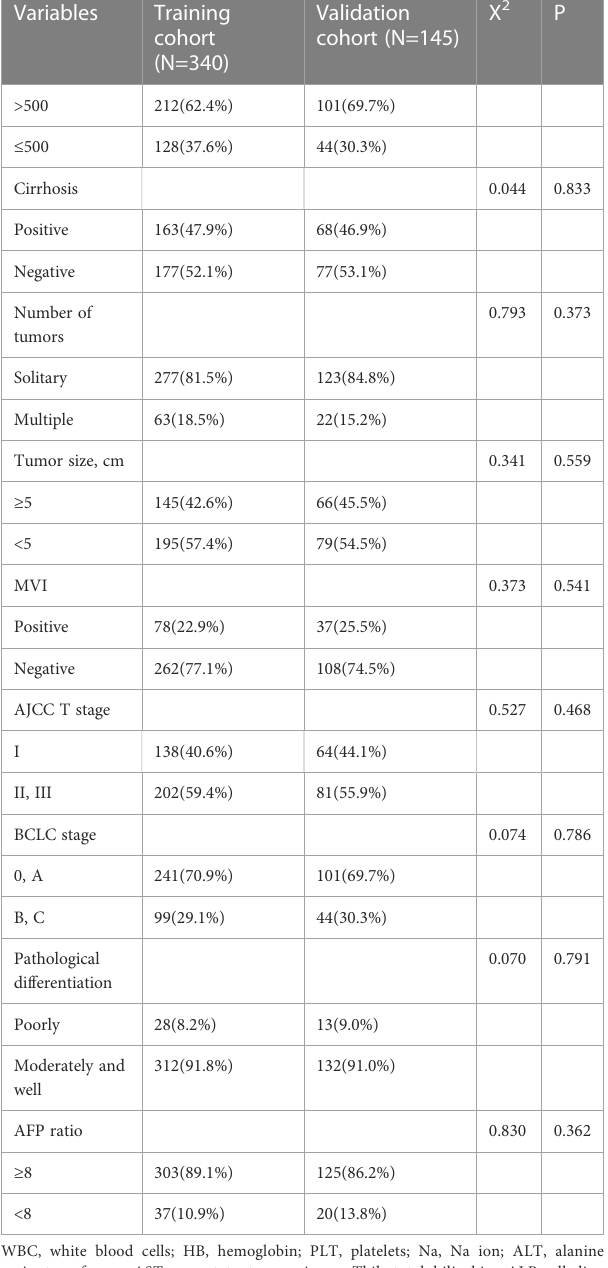
(AFP ratio <0.8) and low-risk (AFP ratio ≥ 0.8) groups using 0.8 as the cut-off threshold. The correlation between the AFP ratio and other characteristics is shown in Table 2. In the training group, there were signi fi cant differences in HBsAg positivity, MVI positivity, and BCLC stage between the high AFP ratio and low AFP ratio groups (P = 0.016, 0.007, 0.017, respectively). In the validation group, there was a signi fi cant difference in BCLC stage between the high AFP ratio and low AFP ratio groups (P = 0.031). As predicted, the AFP levels before hepatectomy of the high AFP